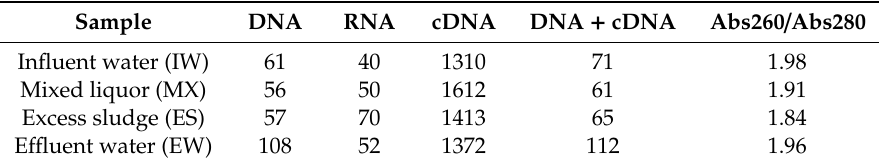
Table 3. Concentration (ng / µ L) of DNA, RNA, cDNA, DNA + cDNA, and Abs260 / Abs280 ratio in the extracted viral nucleic acid